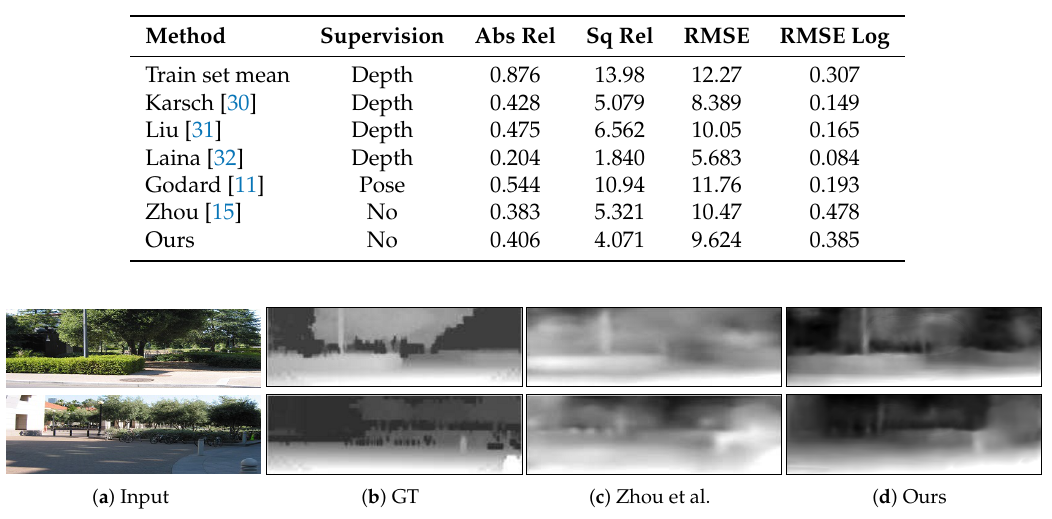
Figure 4. Comparison of monocular depth estimation between failed cases of Zhou et al. [15] and same cases of ours. Our method preserves considerable predictions in vast open scenes and objects close to the front of the camera. Table 5. Depth estimation results on the Make3D dataset.